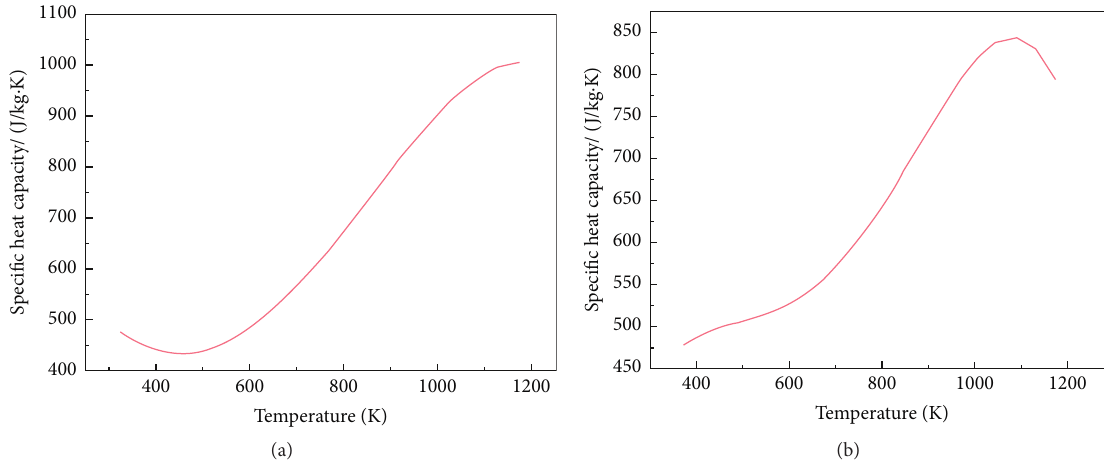
Figure 5: Specific heat capacity curve: (a) BR1500HS; (b) CrMnMo.